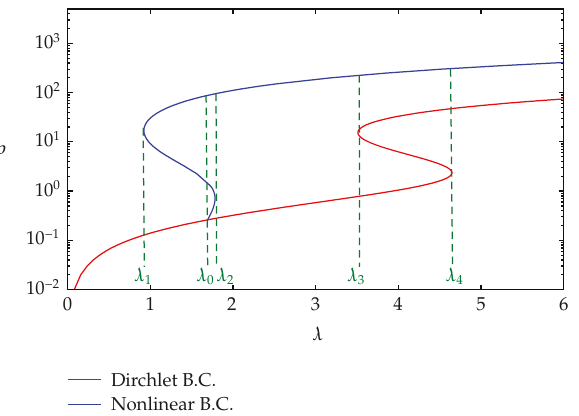
Figure 15: Graph of λ versus ρ for β (cid:3) 5.